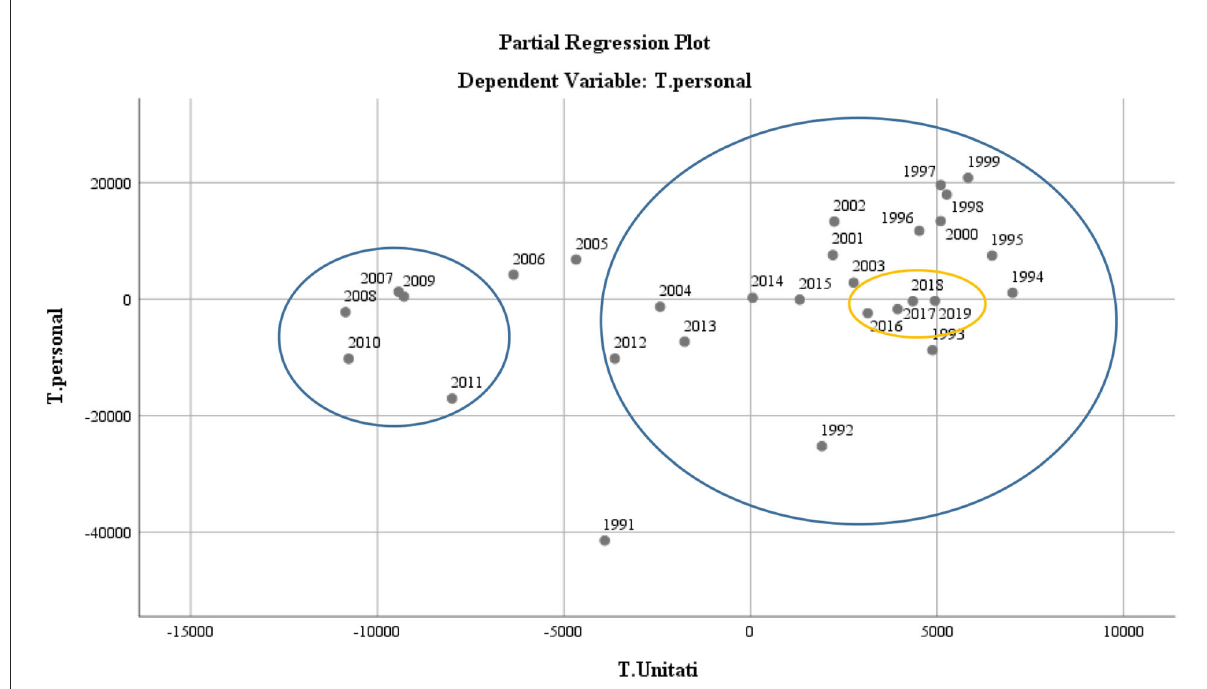
FIGURE5 Scatter diagram representing the dynamics of the staff in the Romanian educational system with the dynamics of school